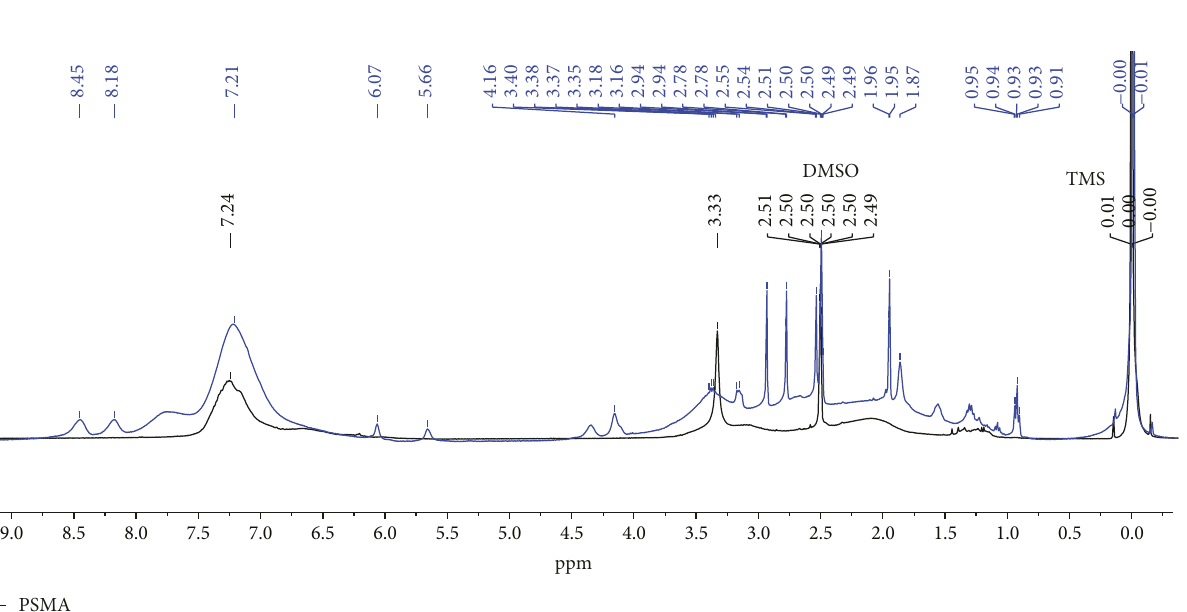
Figure 6: FT-IR charts of PSEA-2 and its starting material PSMA.